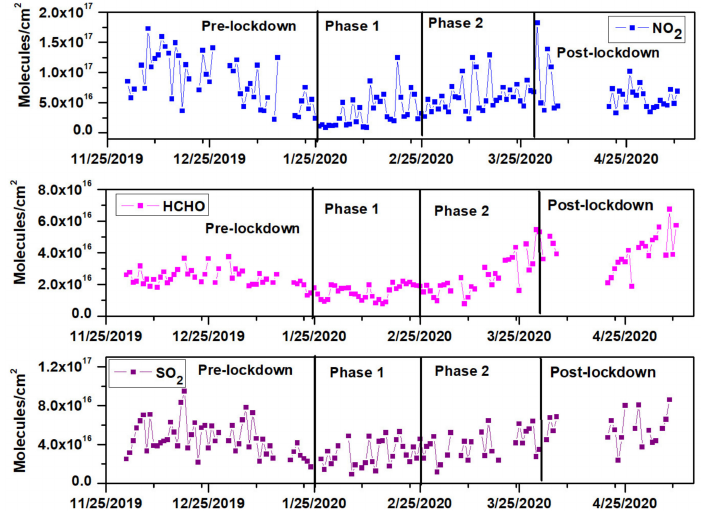
Figure 3. Time series for vertical column density of NO 2 , HCHO, and SO 2 at 30 ◦ elevation viewing angle, obtained from MAX-DOAS observations for the study period over Nanjing. This has been categorized into four phases corresponding to pre-lockdown, lockdown (Phase-1 and Phase-2), and post-lockdown periods.